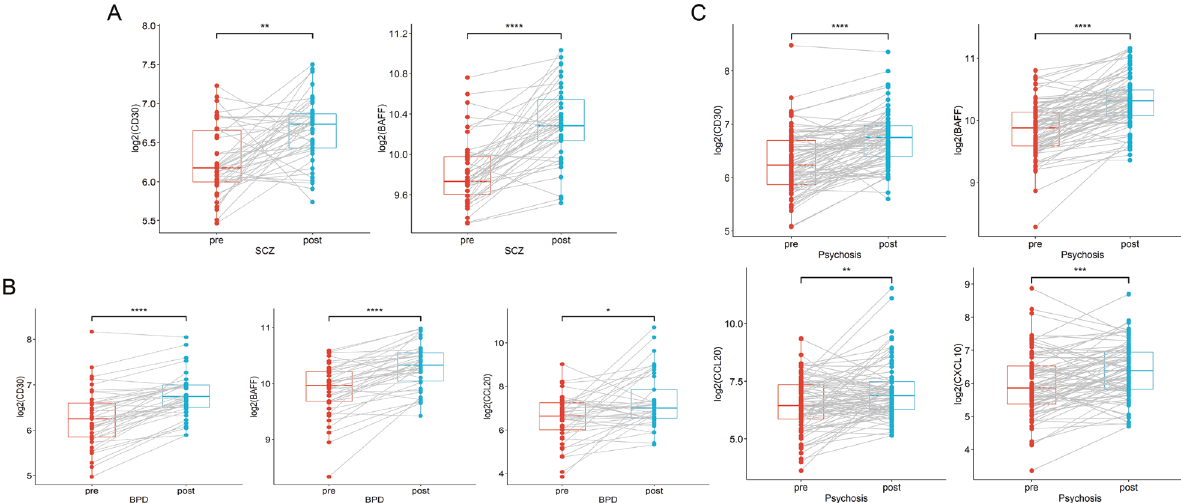
Fig. 1 Signi fi cantly changed IRFs in SCZ or (and) BPD between acute episode and remission. A CD30 and BAFF expression were increased in SCZ patients after treatment ( N = 42 pairs); B CD30, BAFF, and CCL20 expression were increased in BPD patients after treatment ( N = 41 pairs); C CD30, BAFF, CCL20, and CXCL10 expression were increased in the total psychosis (SCZ + BPD) patients after treatment ( N = 83 pairs). Paired t tests were completed to test for statistical signi fi cance and Bonferroni correction was performed for multiple comparisons in different groups. (* p < 0.05; ** p < 0.01; *** p < 0.001; **** p < 0.0001). SCZ schizophrenia; BPD bipolar